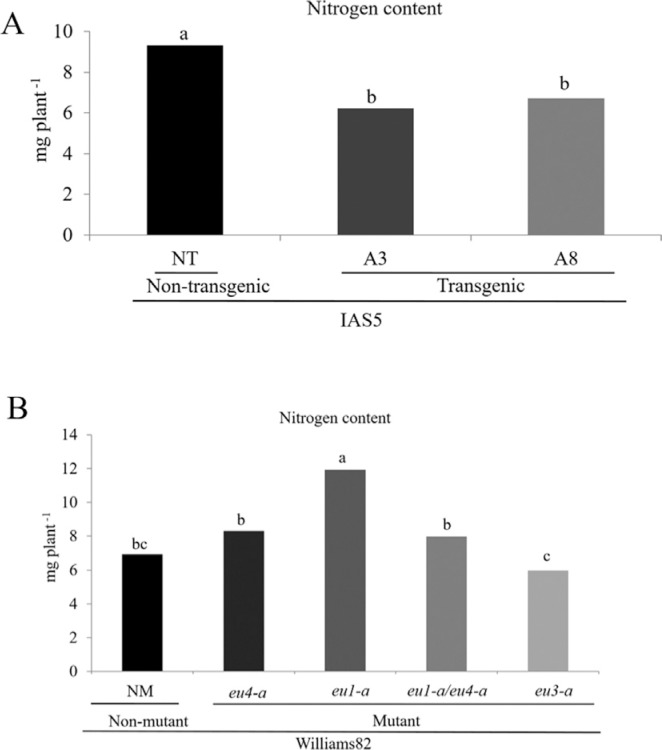
Nitrogen content rate in shoot of soybean at one month after germination. (A) Transgenic and non-transgenic plants were evaluated: 18 plants derived from each event (A3 and A8) and 10 non-transgenic plants. (B) eu4-a, eu1-a, eu1-a/eu4-a and eu3-a mutant and non-mutant plants were evaluated: 18 plants from each mutant and 10 non-mutant plants. ANOVA, p < 0.0001. Means followed by the same letter did not differ by Tukey's post hoc test.